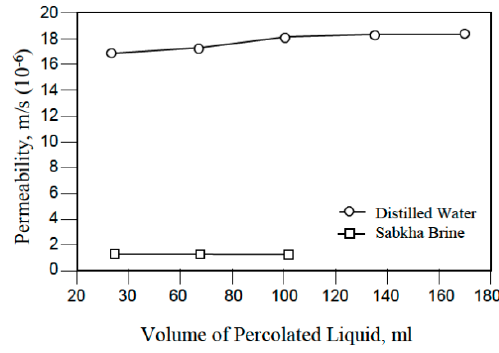
Figure 4. Falling head permeability test results on sabkha soil [5].